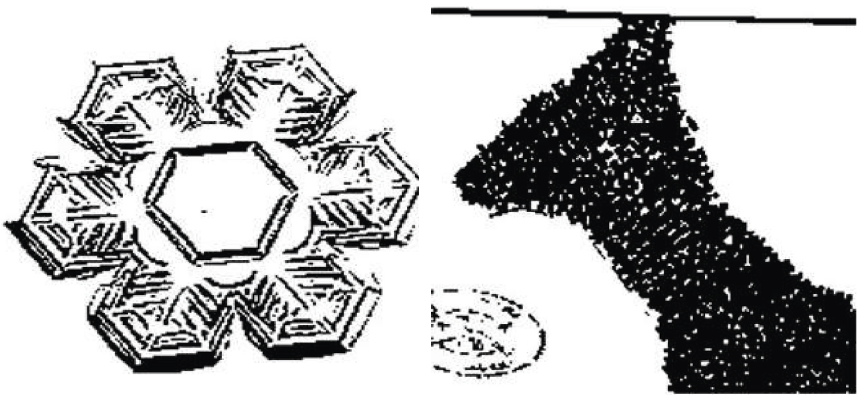
Figure 4: Micro-nano